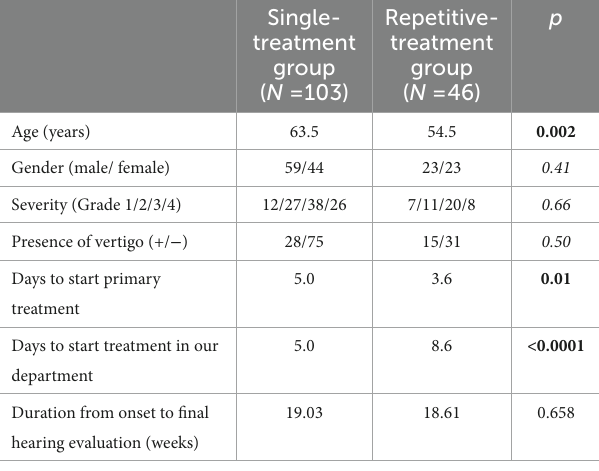
TABLE 3 Patient backgrounds of the two